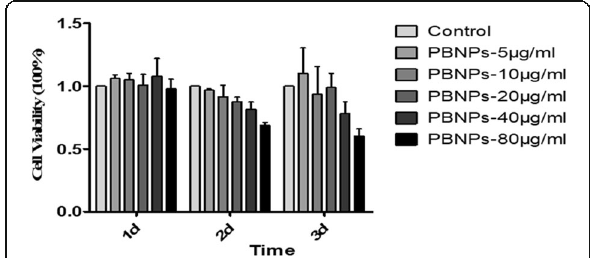
Fig. 3 The viability of C3H10T1/2 cells in the presence of various amounts of PBNPs as determined by the MTT